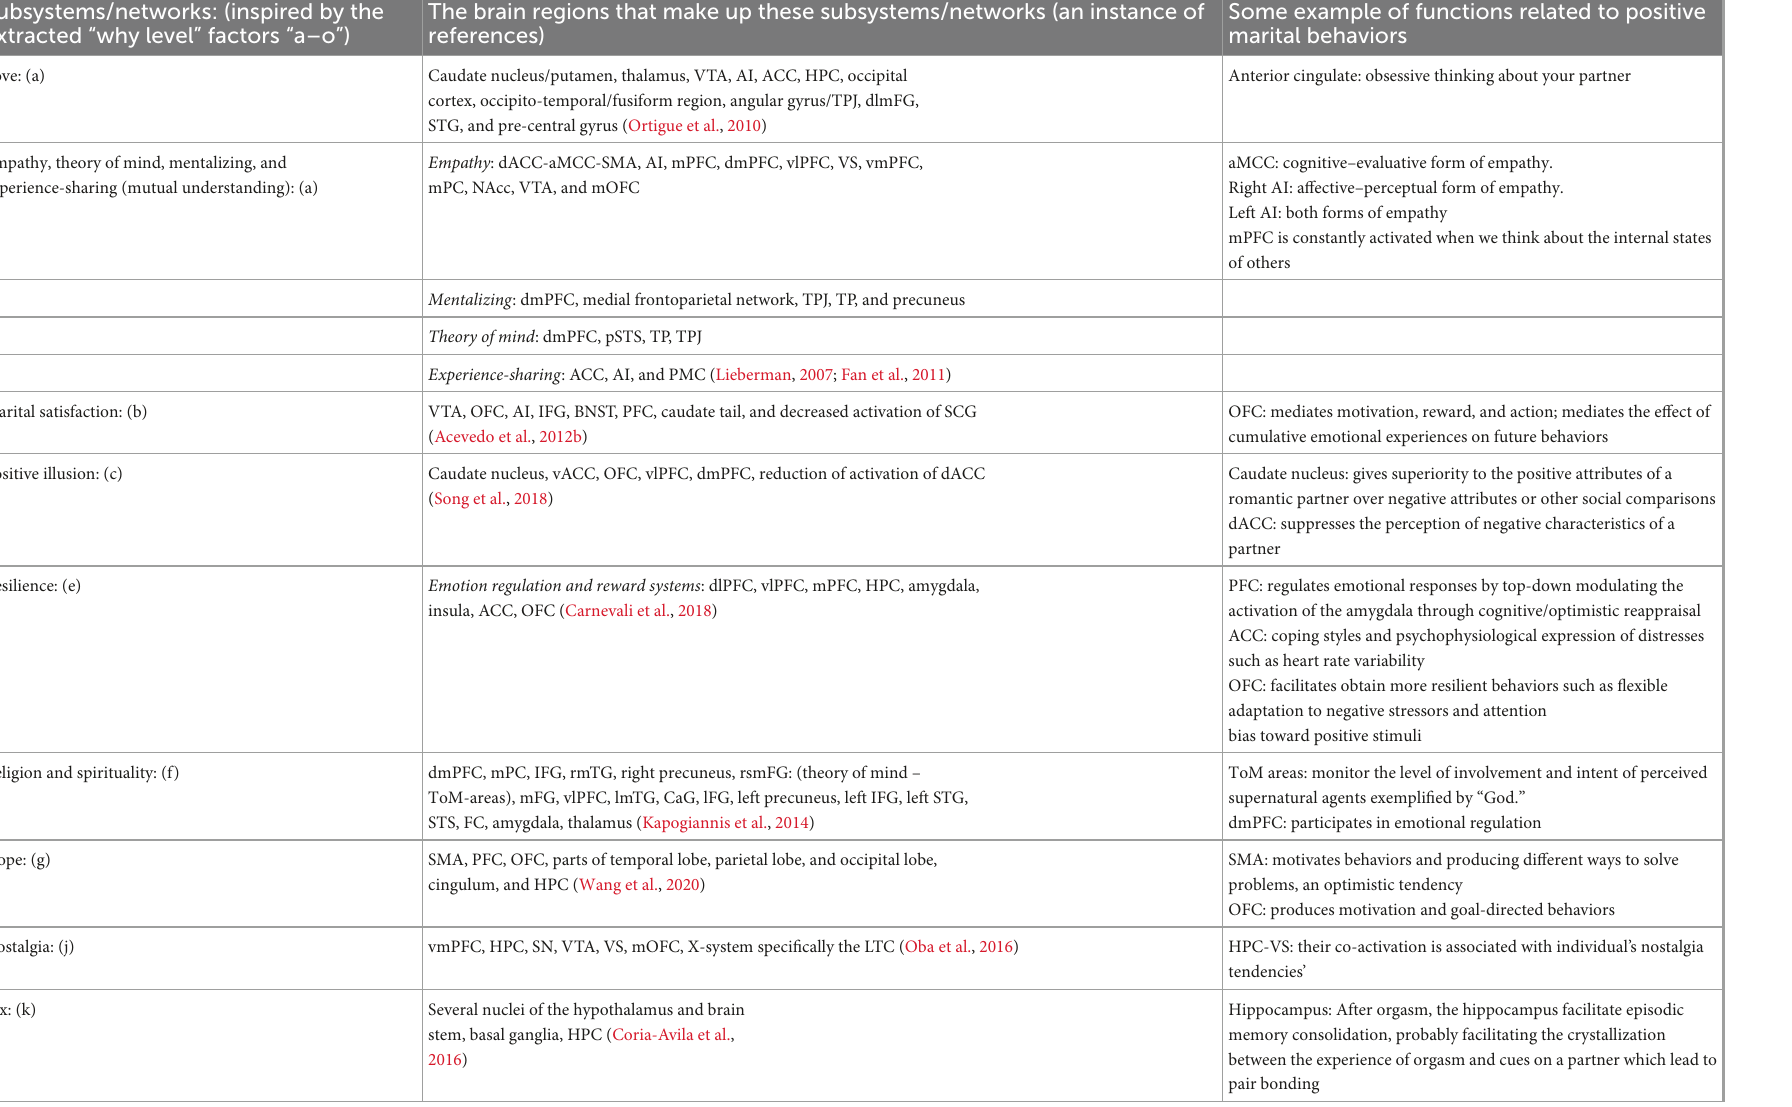
TABLE 1 The proposed brain’s subsystems/networks involved in marital behaviors. Subsystems/networks: (inspired by the extracted “why level” factors “a–o”)